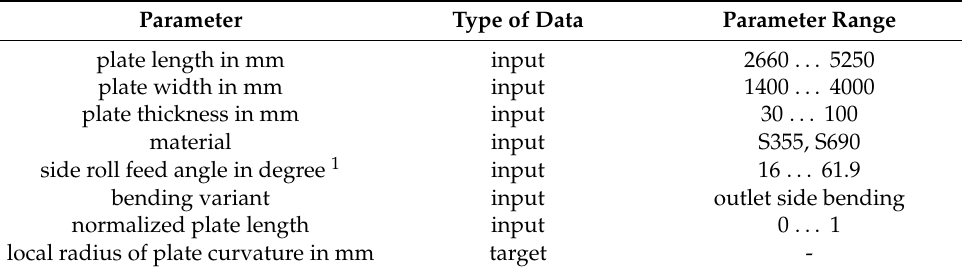
Table 1. Parameter range of the training data for the